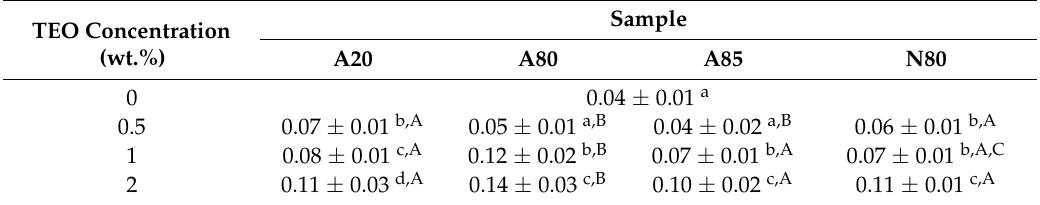
Table 5. Thickness (unit: mm) of chitosan films.